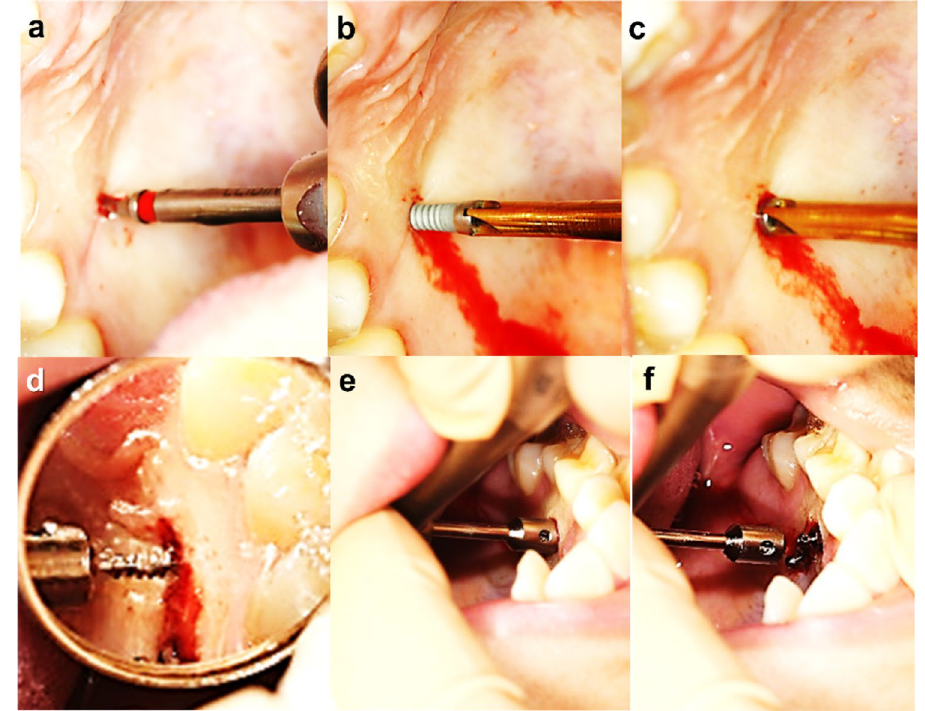
Figure 1. Placement procedure of anchoring miniscrew. ( a ) Predrilling with 1.5 mm in diameter guide drill for the self-tapping C-implant. ( b , c ) 1.8 mm in diameter 9.5 mm in length screw part (8 mm of miniscrew under the mucosa) is placed using a manual driver, ( d – f ) the 1.6 mm in diameter 8 mm in length self-drilling miniscrews is placed without